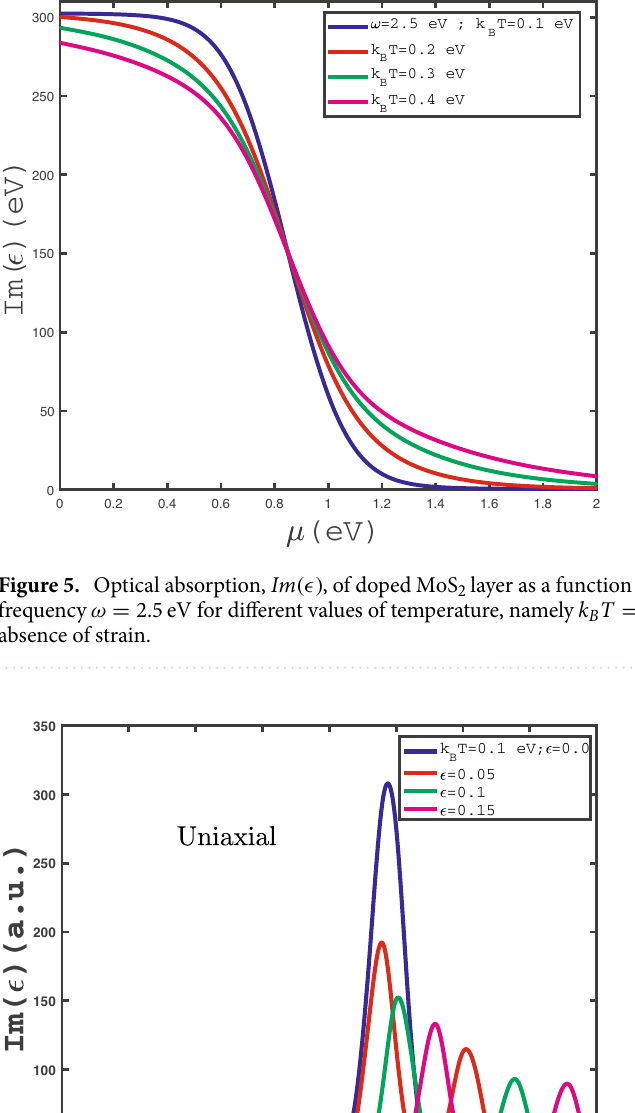
Figure 6. Optical absorption, Im (ǫ) , of undoped MoS 2 layer as a function of photon frequency in the presence of positive uniaxial strain for different strain parameter , namely ε magnetic field at fixed temperature k B T